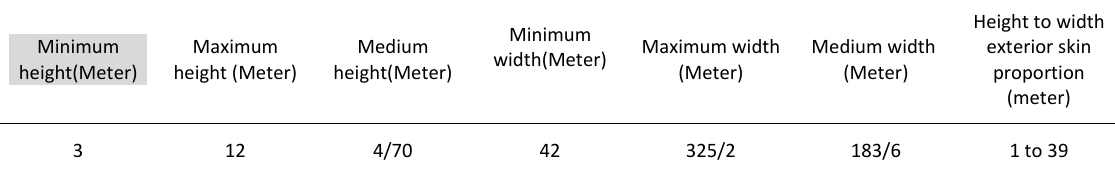
Table 5: Proportions of Yazd district passages exterior skin